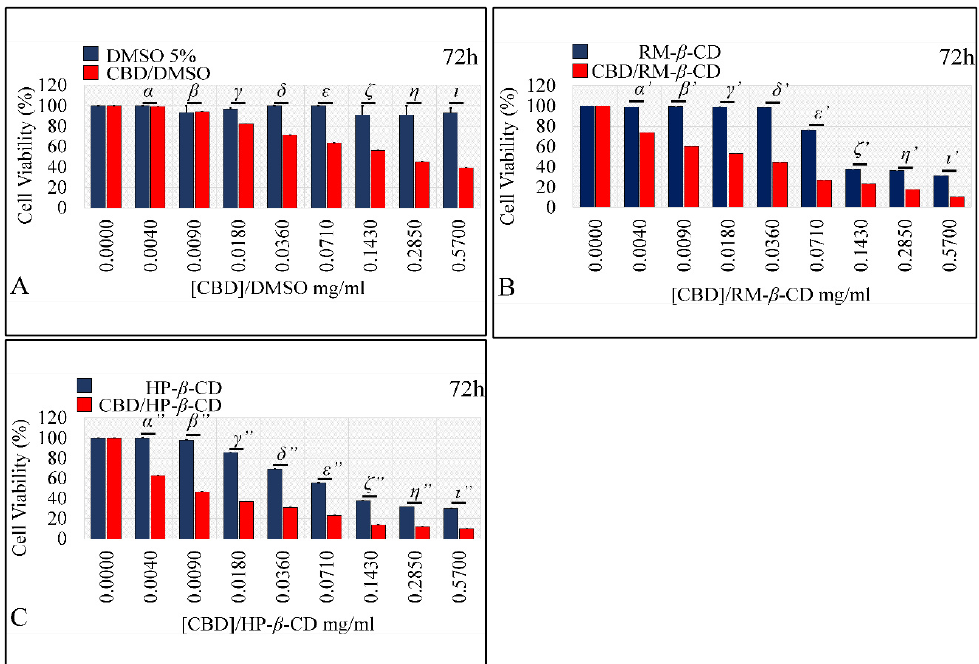
Figure 15. Comparison of vehicle-only and vehicle/CBD complexes on TE671 cells at 72 h. DMSO did not have any effect on cells, while the DMSO/CBD solution manifested significant cytotoxicity as compared to the vehicle ( A ) at all concentrations, except for the 0.004 and 0.009 concentrations. RM- β -CD ( B ) and HP- β -CD ( C ) had a cytotoxic effect, but their complexes manifested significantly higher cytotoxicity at all concentrations tested. The Greek letters above each bars-pair indicate the obtained p-value. In particular, p -values for the DMSO, CBD/DMSO comparison were: α = 0.03, β = 0.83, γ = 0.001, δ = 0.00001, ε = 0.000007, ζ = 0.018, η = 0.012, ι = 0.003. The p -values for